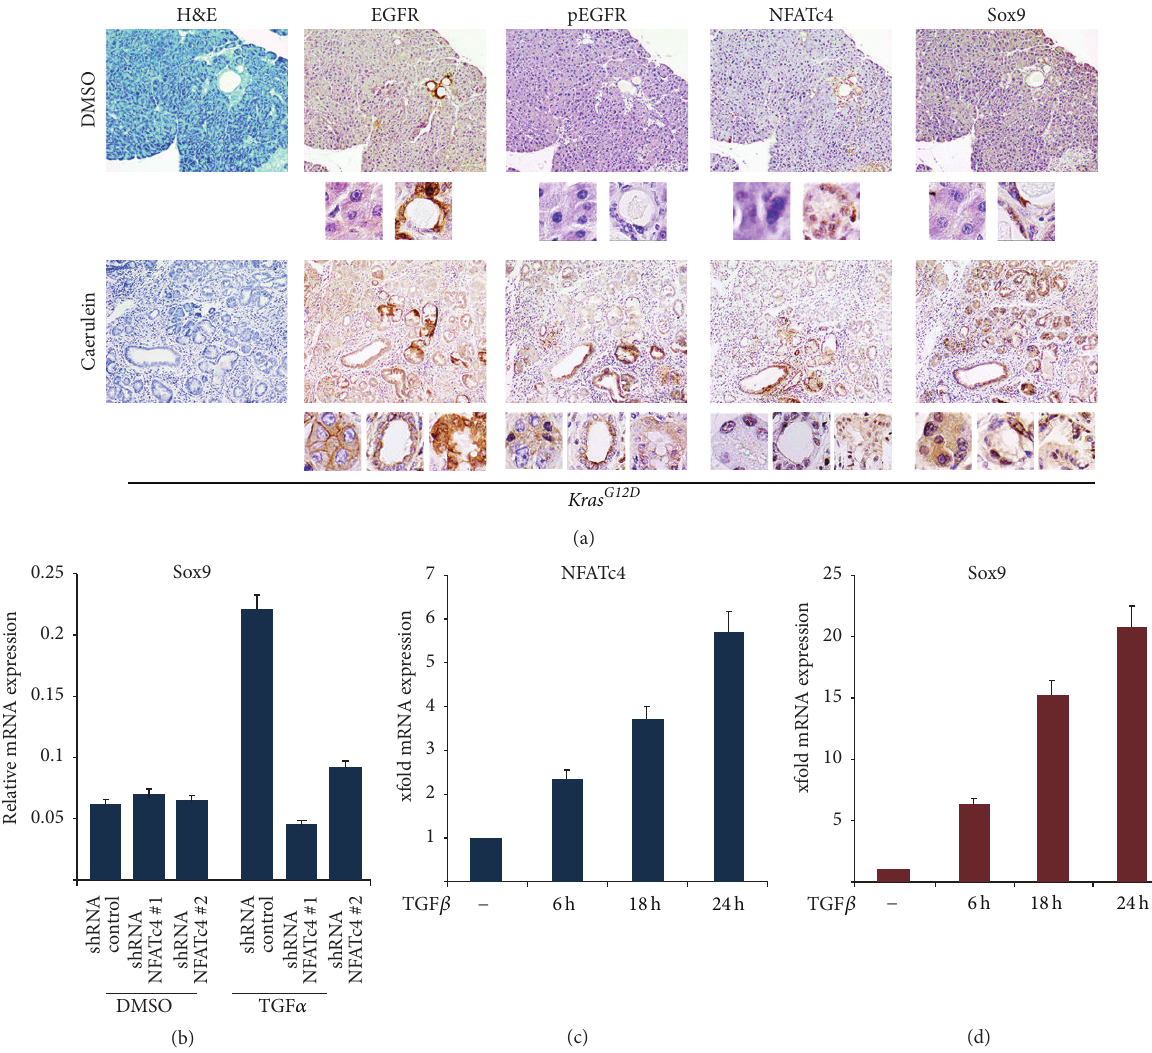
Figure 3: NFATc4 activation in metaplastic cells is associated with transcriptional induction of Sox9 . (a) H&E staining as well as immunohistochemistry in 3-month-old Kras G12D ; pdx1-Cre mice following a four-week spanning treatment with caerulein or DMSO. The black boxes beyond the immunohistochemical staining display representative magnifications of normal acinar cells (left boxes), ADM (right box for the control group, middle box for the caerulein-treated mice), and PanIN lesions (right boxes in the caerulein cohort). (b) qRT-PCR reveals Sox9 mRNA expression in acinar cell explants from wildtype mice following genetic depletion of NFATc4 and TGF 𝛼 stimulation for 5 days. (c)-(d) Primary pancreatic tumor cells from Kras G12D ; 𝑝53 Δ/𝑤𝑡 ; pdx1-Cre mice were treated with TGF 𝛽 for the indicated time points. mRNA expression of NFATc4 (c) and Sox9 (d) was determined by using qRT-PCR.